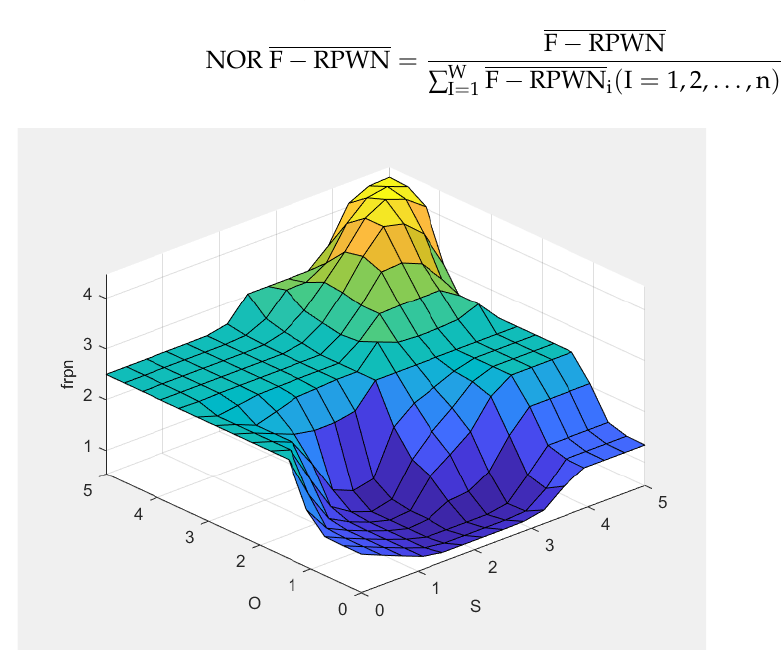
Figure 4. Severity, Detection, and FRPN 3D Map View.